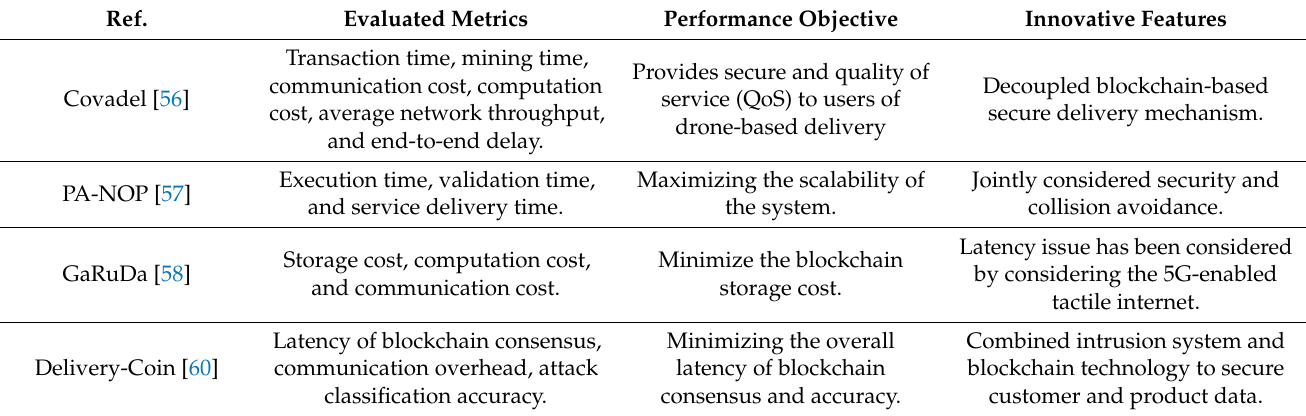
Table 7. Comparison of security algorithms in drone routing in terms of evaluated metrics, perfor- mance objective, and innovative